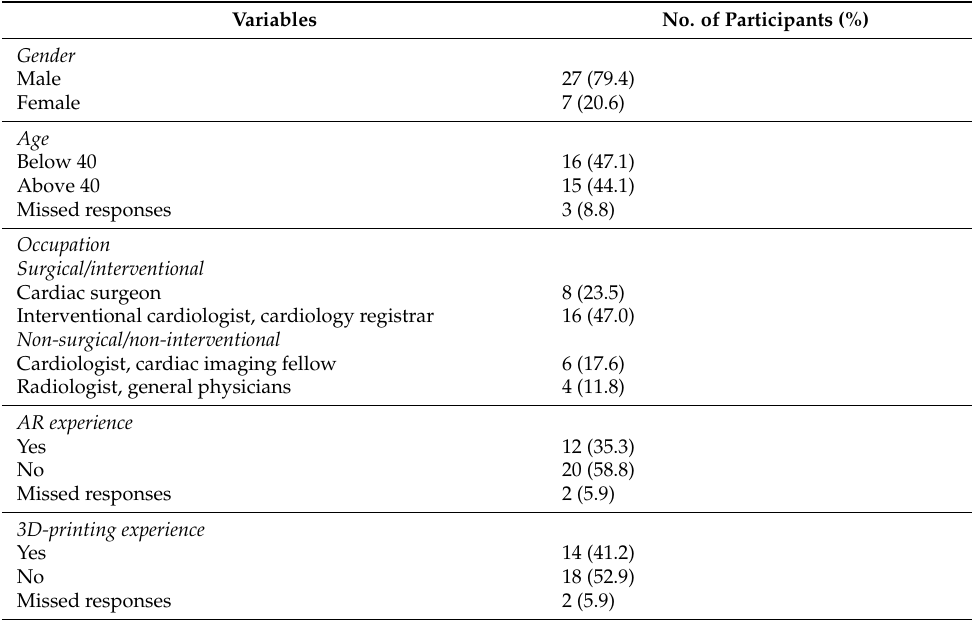
Table 1. Characteristics of study